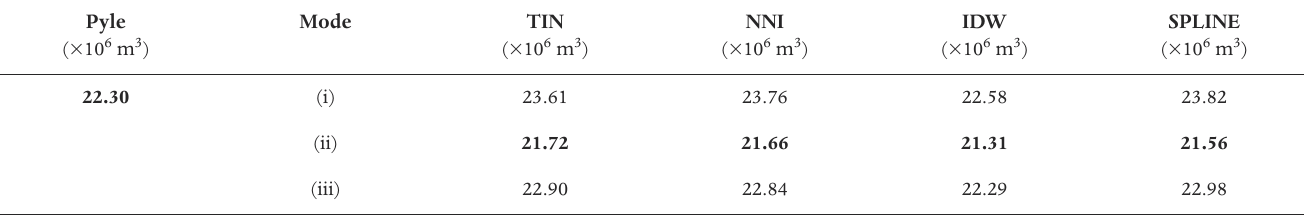
Table 4. Volumes of the 'ideal' fallout deposit, calculated using the different methodologies (Pyle, TIN, NNI, IDW, SPLINE) and modes (i, ii, iii). See text for